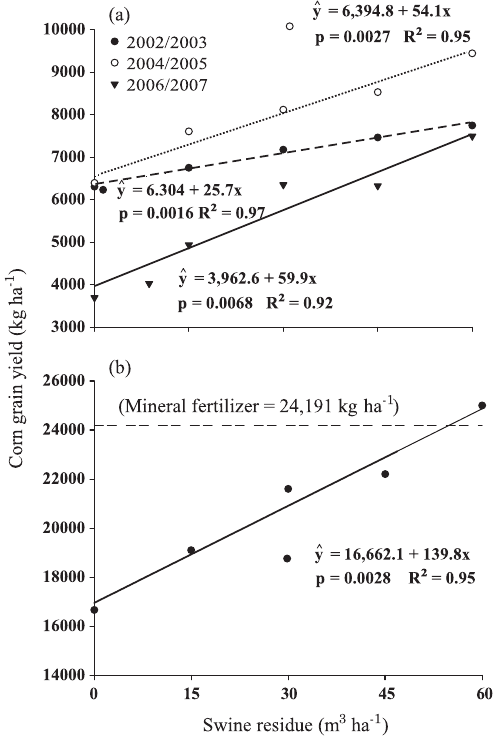
figure 1. corn grain yield (kg ha -1 ) as related to the application of swine residue rates of 0, 15, 30, 45, and 60 m 3 ha -1 in the growing seasons 2002/2003, 2004/2005 and 2006/2007 (a) and cumulative corn yield of three harvests, comparing to the use of mineral fertilizer and swine slurry